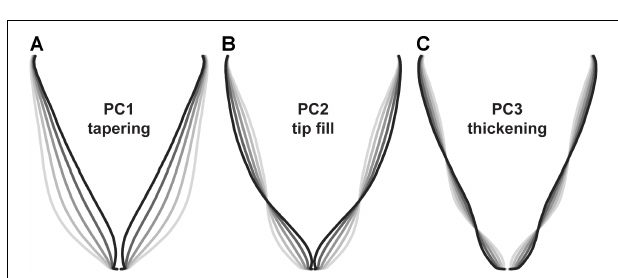
FIGURE 6 | Eigenvectors for principal components analysis of carrot root shape after normalization for aspect ratio ( n = 917 individuals). Lines represent a parameter sweep of the principal component, capturing symmetrical variation in root shape. (A) Changes in PC1 modified the extent of root tapering (conical vs. cylindrical) and explained 66.4% of the observed variation. (B) Changes in PC2 reflected the degree of tapering at the tip of the root (i.e., tip fill) and explained 16.6% of the observed variation. (C) Changes in PC3 captured variation for thickening in the longitudinal section of the root and explained 5.6% of the observed